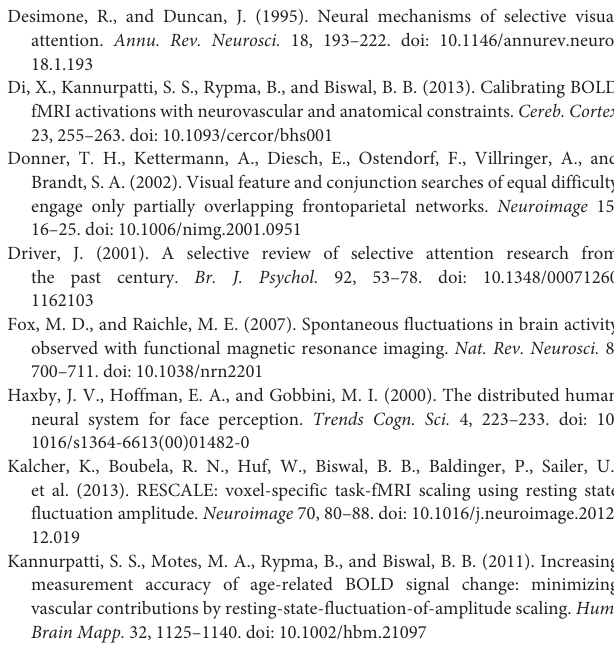
FIGURE 4 | Scatter plot shows the Pearson correlation between PLE and averaged ALFF in left ITG (A) and left precentral/postcentral gyrus (B) respectively, while the age,